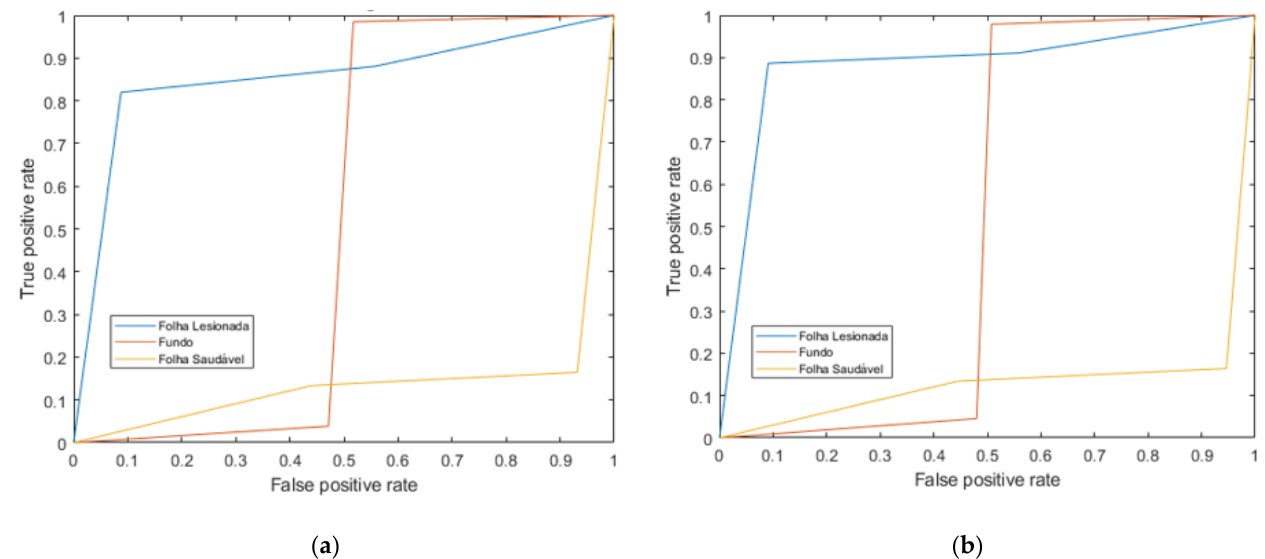
Figure 7. Comparison of Receiver Operating Characteristic (ROC) curves for each class for the CNN models of ( a ) GoogleNet and ( b ) ResNet50.